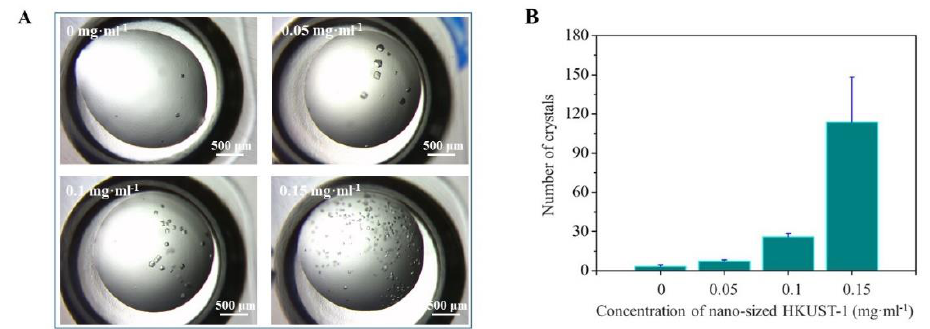
Figure 4. ( A ) Protein crystallization trials of lysozyme at a final concentration of 10 mg · mL − 1 in presence of nano-sized HKUST-1, lysozyme control (top left), 0.05 mg · mL − 1 (top right), 0.1 mg · mL − 1 (bottom left), 0.15 mg · mL − 1 (bottom right) of nano-sized HKUST-1. ( B ) Nucleation density (number of crystals/drop) of lysozyme upon the increase in the concentration of nano-sized